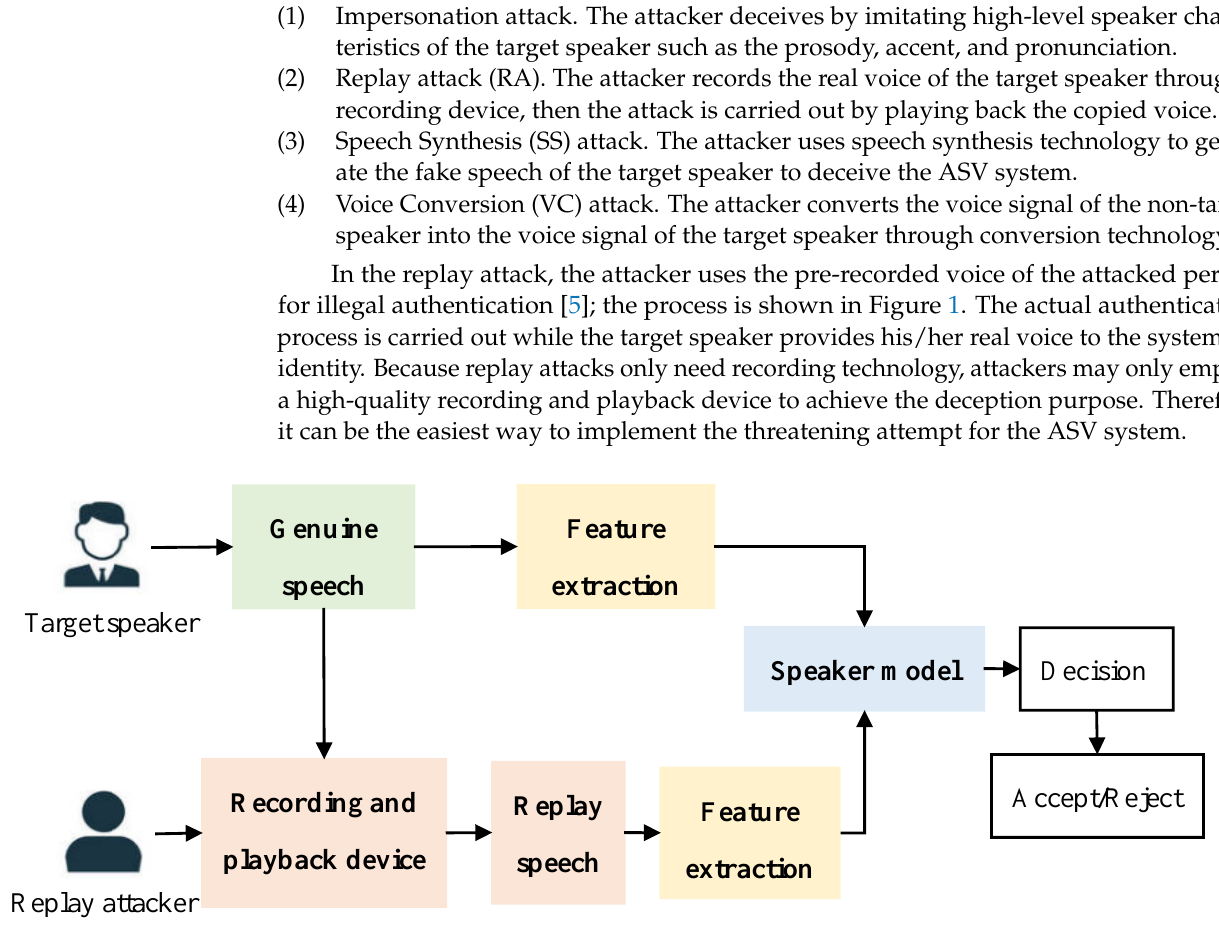
Figure 1. The process of replay attack.